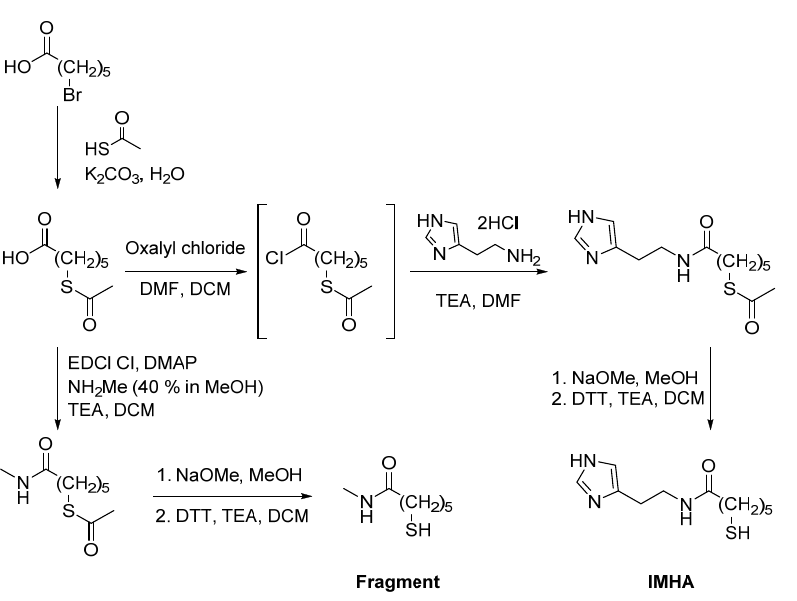
Figure 1. Synthesis scheme of IMHA and fragment molecule.